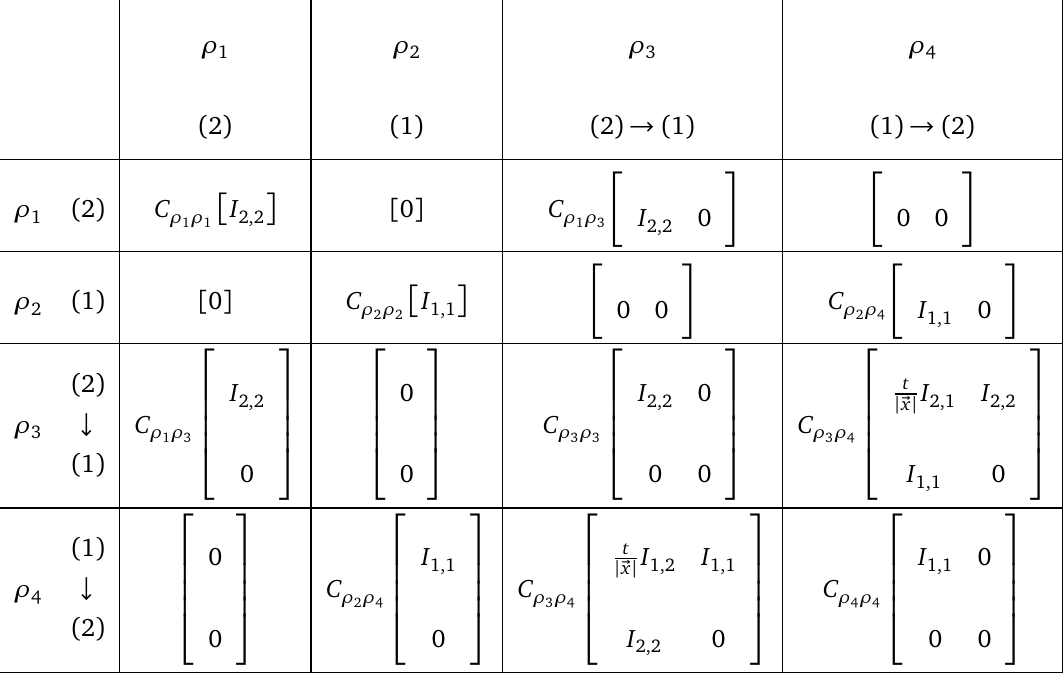
Table 4: The 2-pt correlators between the operators in (4.43), where we have left out the scaling part | ⃗ x | − ∆ i − ∆ j for simplicity. Here we require the exchange symmetry 〈 O 〉 = 〈 O 〉 , and thus there are seven independent 2-pt O O 1 2 2 1